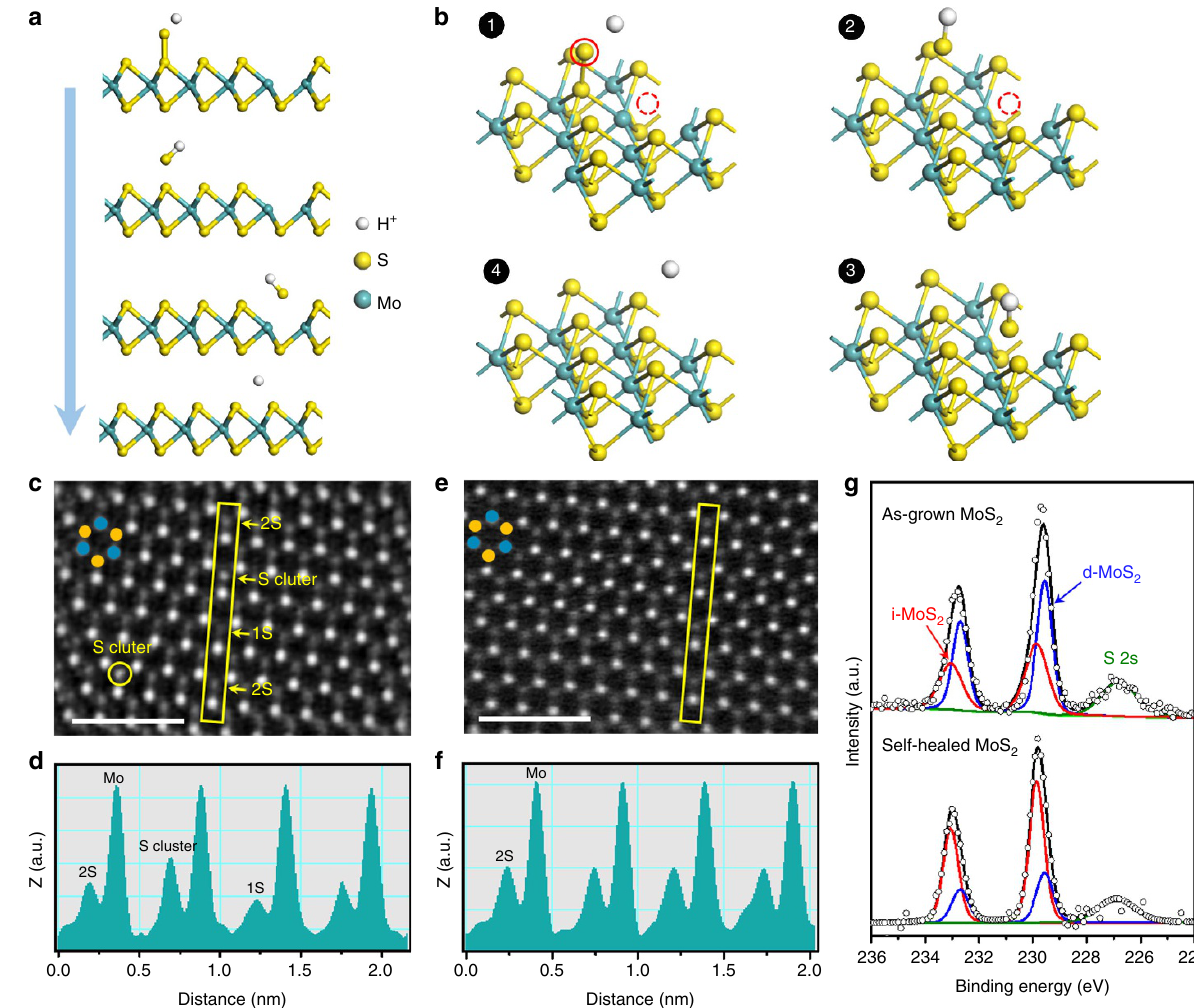
Figure 2 | Sulfur vacancy self-healing (SVSH) mechanism. ( a , b ) 2D/3D chemical structure change showing the PSS-induced SVSH effect. ( c – f ) The